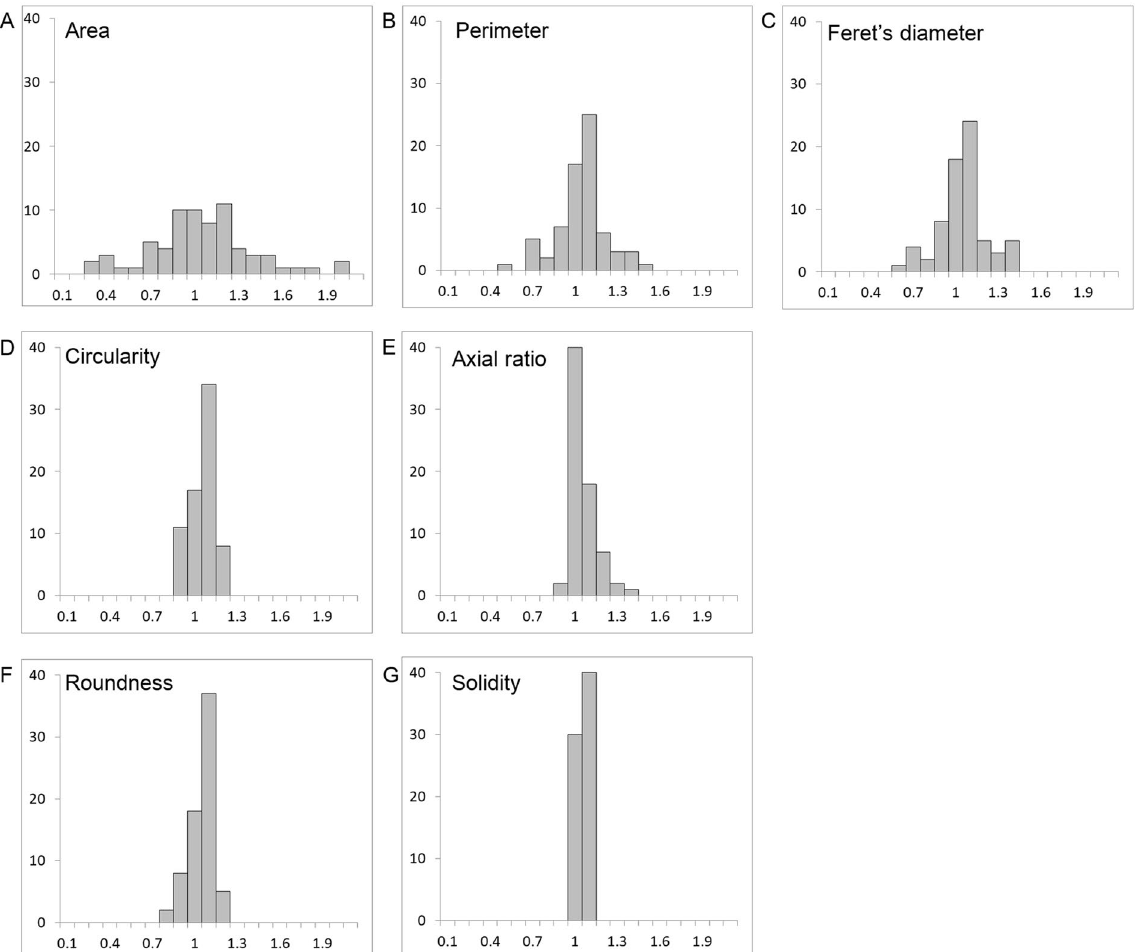
Figure 1. Histograms normalized by the average of each parameter. The coefficient of variation of the parameters related to the size of the FAZ, viz., the area ( A ), perimeter ( B ) and Feret’s diameter ( C ), were larger than that for the parameters associated with the shape of the FAZ, viz., circularity ( D ), axial ratio ( E ), roundness ( F ), and solidity ( G ).